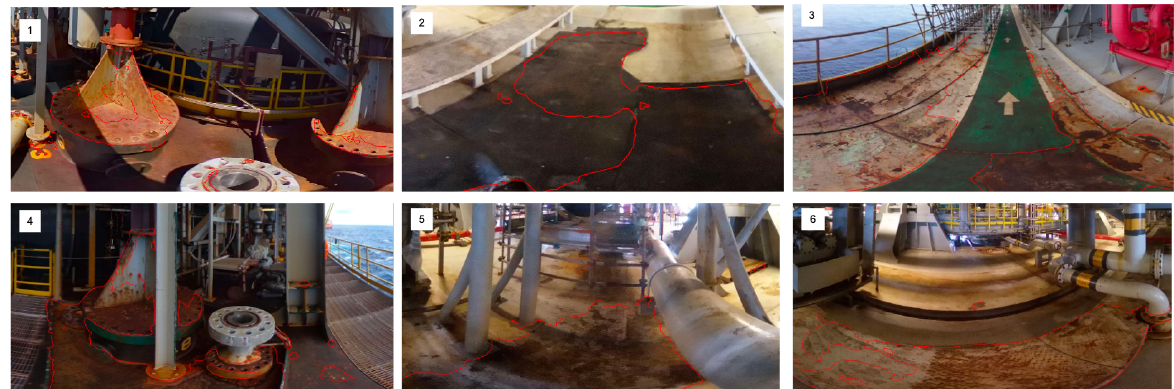
Figure 10. Sample images: examples of reference segmentation (upper row) and prediction (lower